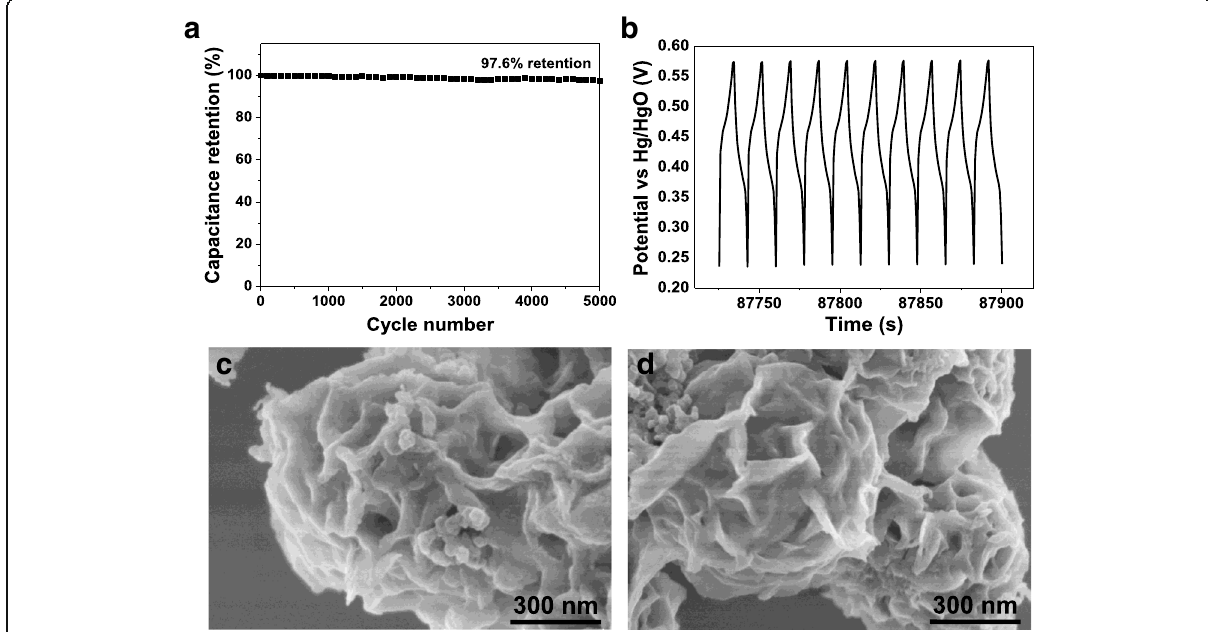
Fig. 8 a Cyclic performance of Ni 3 Si 2 O 5 (OH) 4 /RGO microsphere electrode at the current density of 6 A g – 1 for up to 5000 cycles. b The charge/ discharge curve of Ni